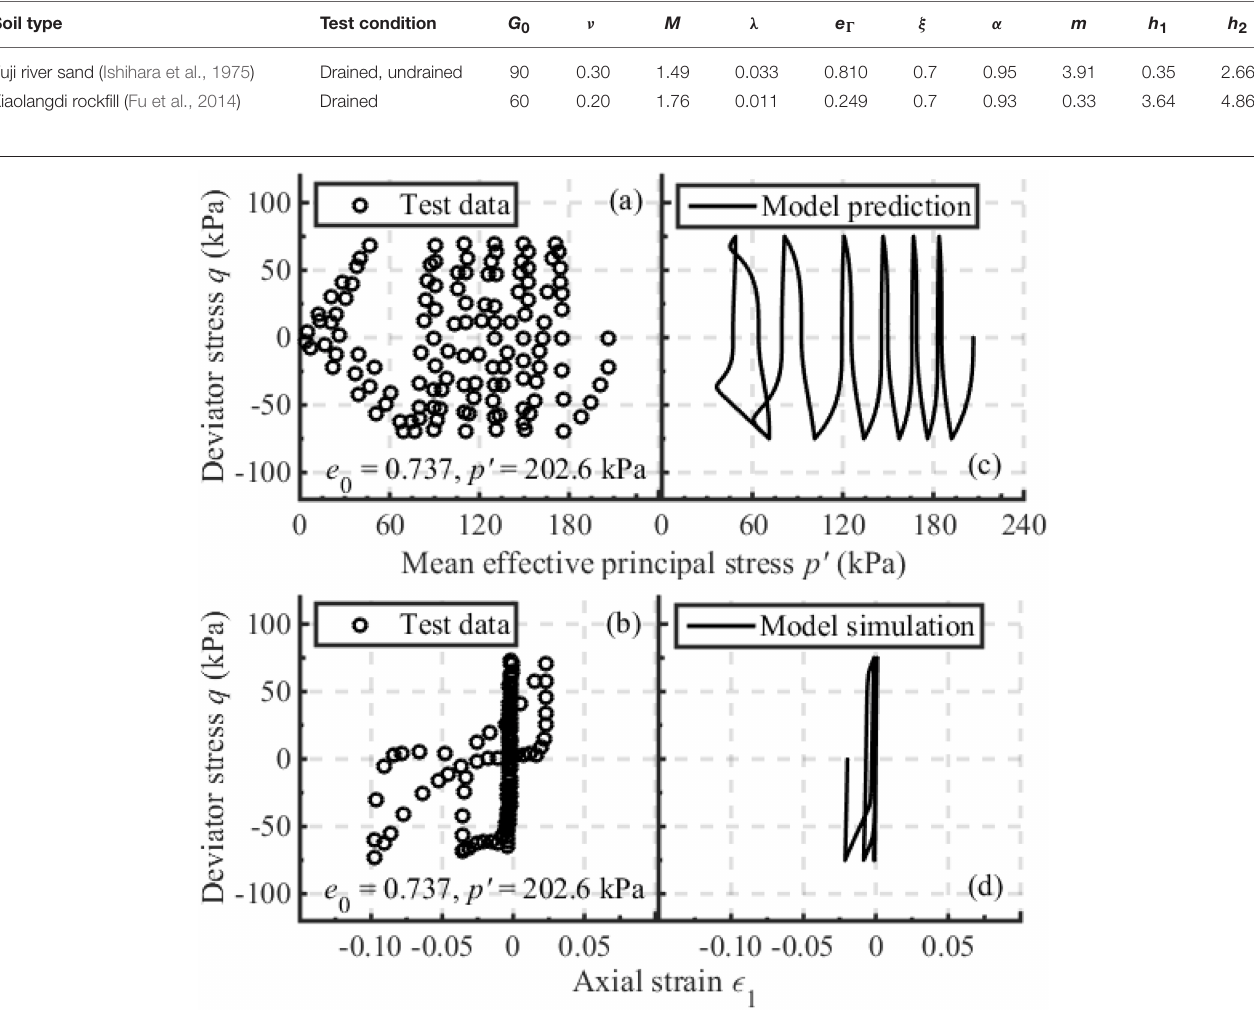
FIGURE 3 | Model prediction of the undrained cyclic behavior of Fuji River sand (Ishihara et al., 1975) (a) measured deviator stress vs. measured mean effective principal stress, (b) measured deviator stress vs. measured axial strain, (c) predicted deviator stress vs. predicted mean effective principal stress, (d) predicted deviator stress vs. predicted axial